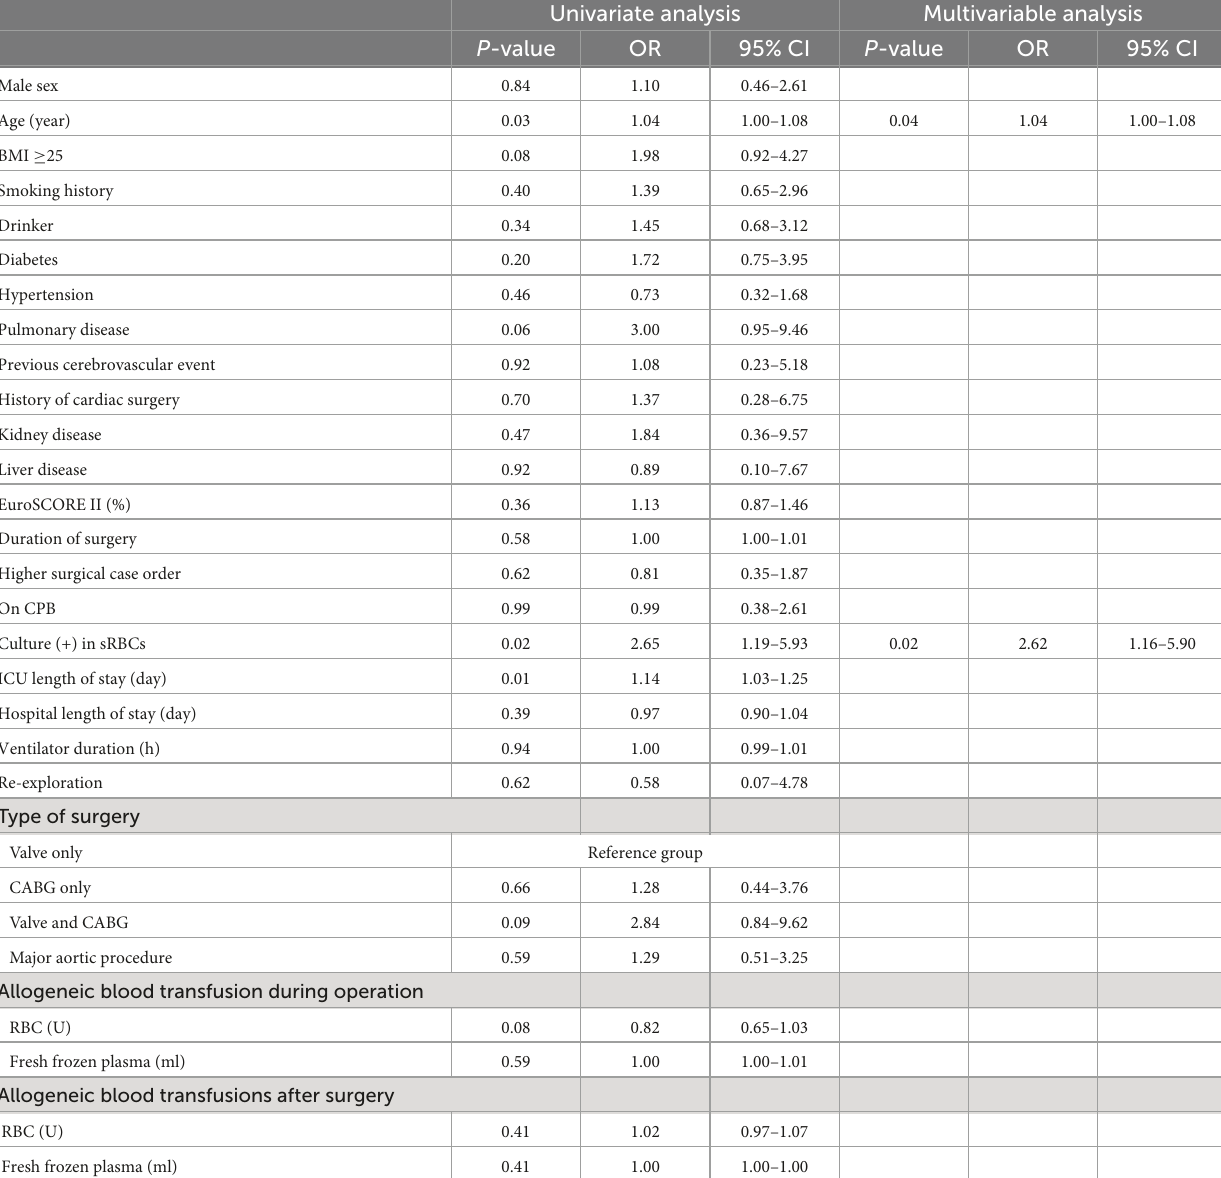
TABLE 5 Univariable analyses and multivariable models for independent factors associated with postoperative